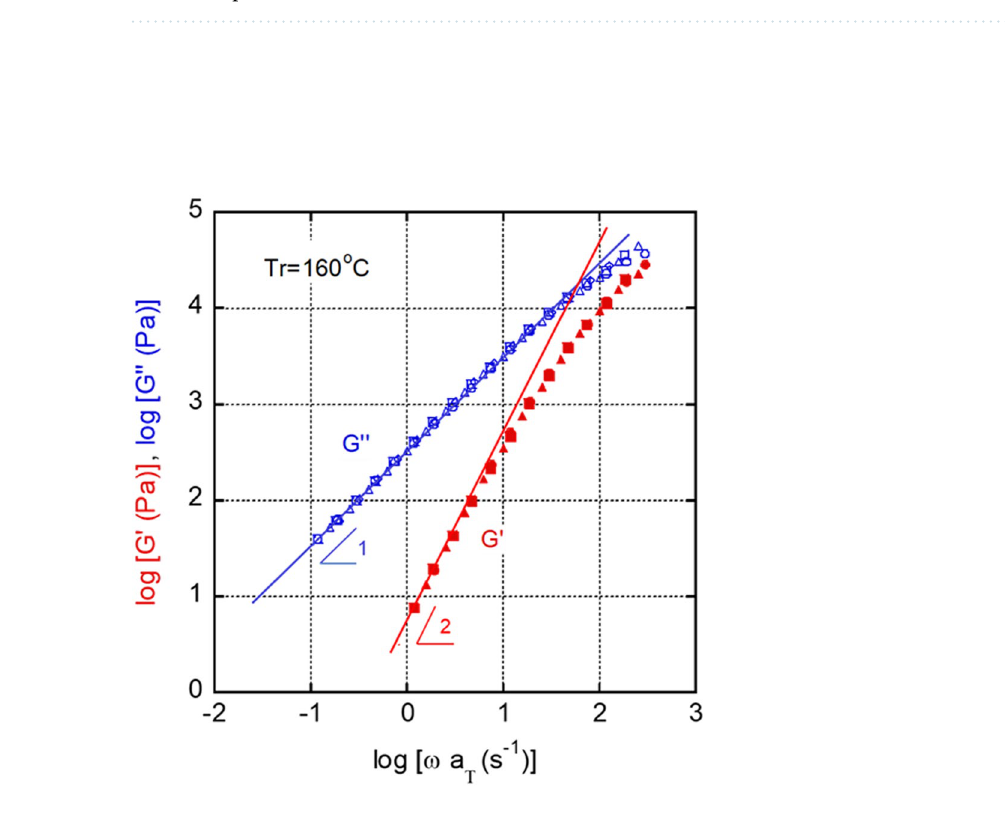
Figure 1. Experimental protocols. Investigations of crystallization during the cooling process (top) and the isothermal process (bottom).